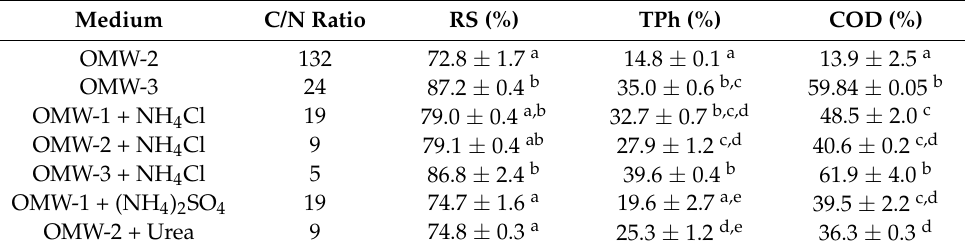
Table 4. Values of the consumption of reducing sugars (RS), total phenols (TPh), and the chemical oxygen demand (COD) obtained in C. tropicalis ATCC 750 batch cultures carried out in Erlenmeyer flasks with and without the addition of an external nitrogen source. Data are the average ± standard deviation of two independent replicates. Values followed by the same letter in each column do not present statistically significant differences ( p ≤